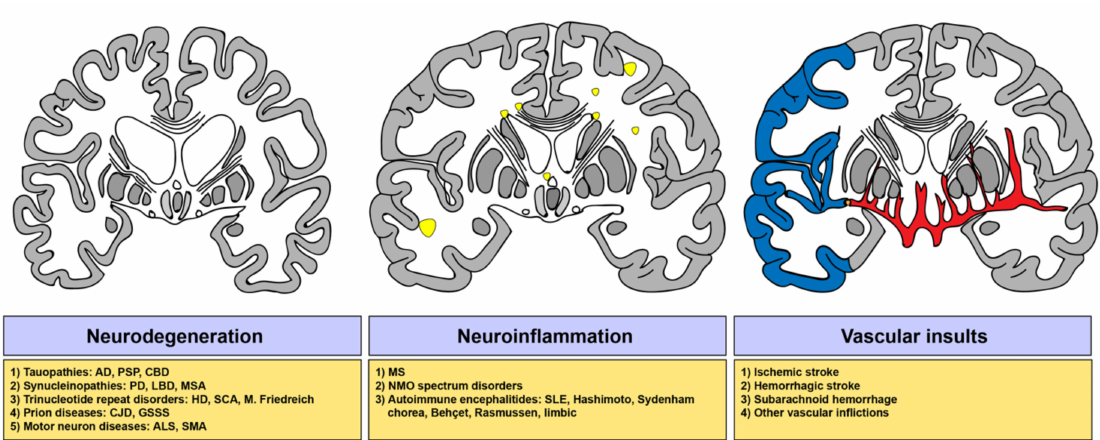
Figure 3. Clinical significance of distorted sphingosine 1-phosphate signaling in neurological disorders. Perturbed S1P signaling has been reported in various clinical conditions ranging from autoimmunity, infection, and cancer. S1P signaling was also shown to play a detrimental role in several neurological diseases, including neurodegenerative and neuroinflammatory conditions, but equally in cerebrovascular insults resulting in stroke or subarachnoid hemorrhage. The yellow patches refer to demyelinated / inflamed areas in the white matter. The area of the grey matter (grey) highlighted in blue denotes the infarcted region. This region is perfused by the middle cerebral artery (here blocked by an embolus), a branch of the cerebral vessel system